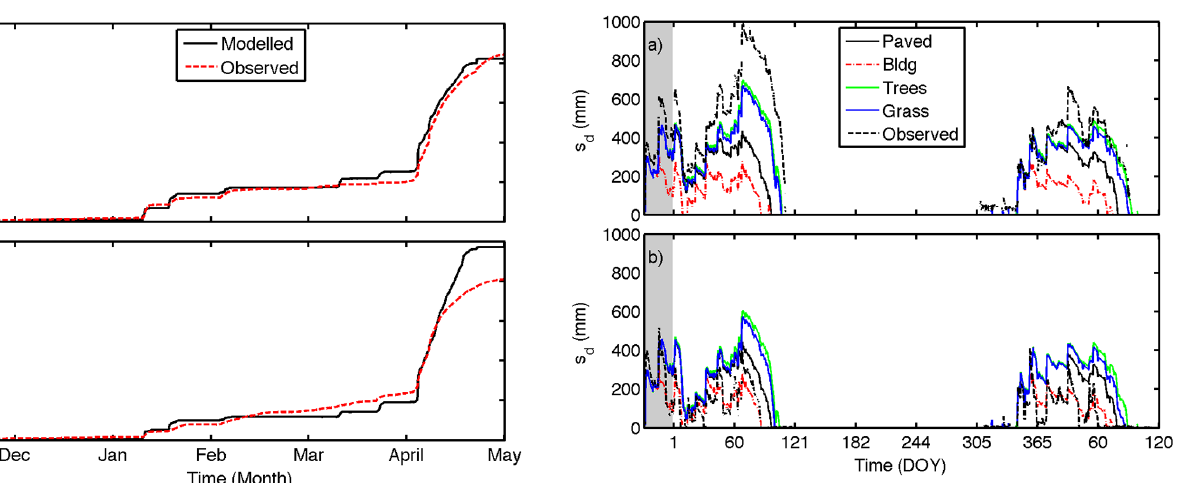
Figure 6. Modelled and observed cumulative runoff during the snow covered period (19 November 2010–31 April 2011) (a) Pa and (b) Pi (independent) catchments.